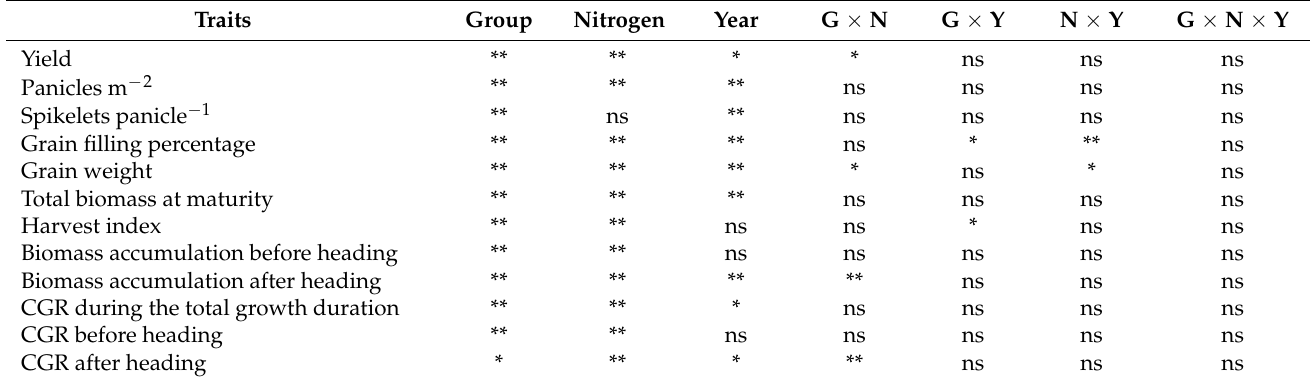
Table 2. Analysis of variance on yield-related traits of different types under different N